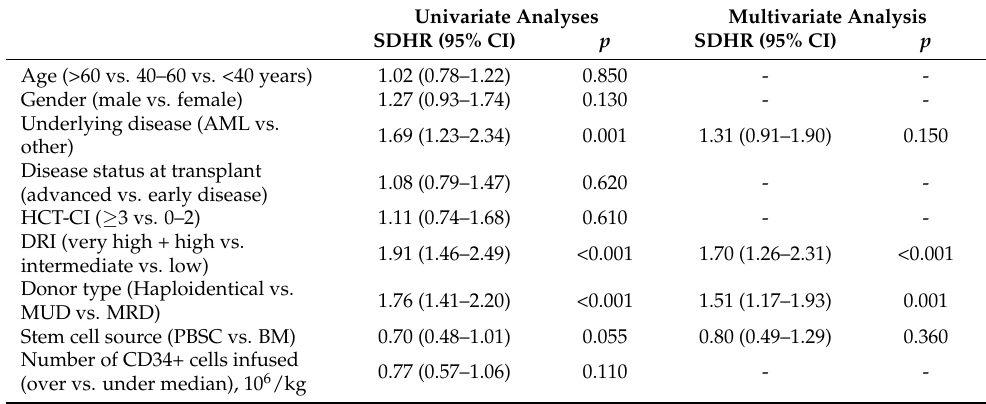
Table 3. Univariate and multivariate competing risk regression for bacterial BSI after